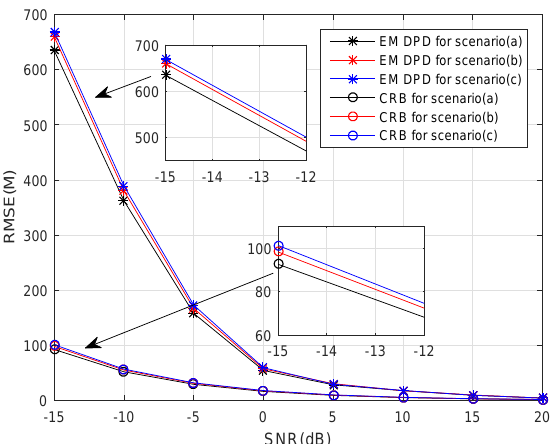
Figure 2. The RMSE and Cramér–Rao bound (CRB) versus SNRs for different scenarios.